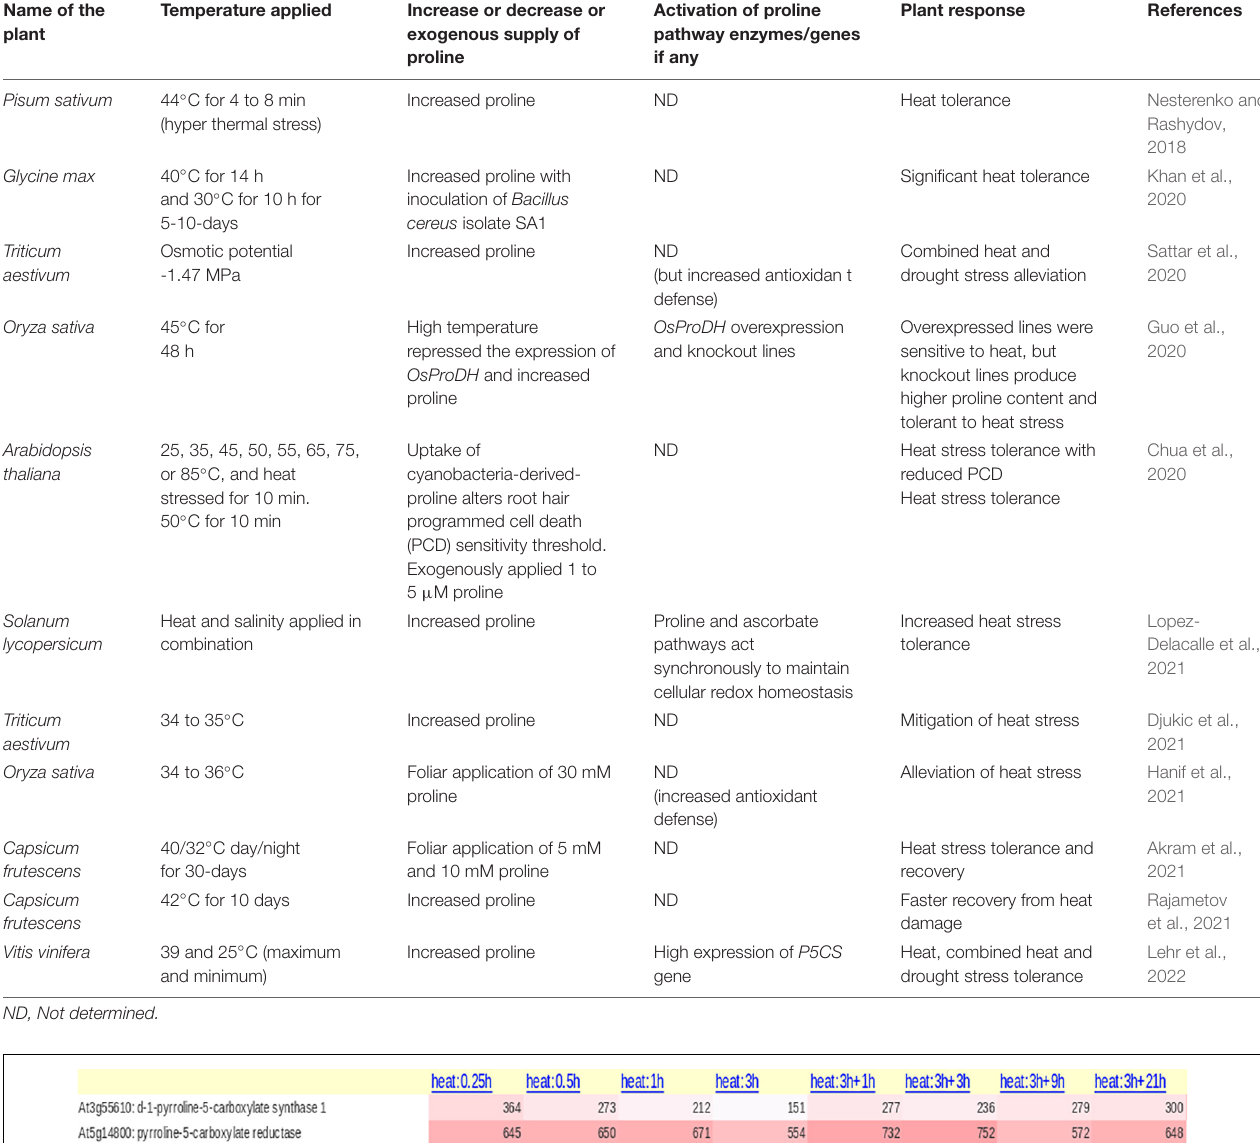
physically. DFR1 protein mediates the inhibition of proline degradation and modulates drought and freezing tolerance (Ren et al., 2018). P5CDH is also crucial to degrade the toxic effects of proline in plants or its intermediate glutamic semialdehyde/P5C to glutamate releasing the reducing power in